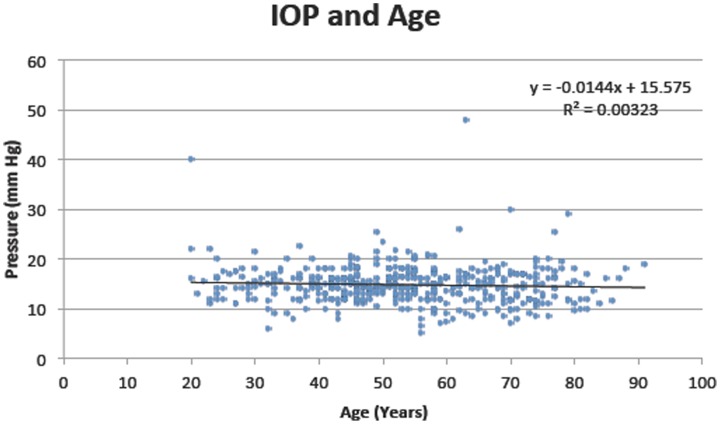
Average intraocular pressure against age.Formula for the regression: y = −0.0144×+15.575, r2 = 0.003.